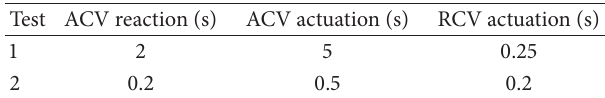
Table 1: Closure times